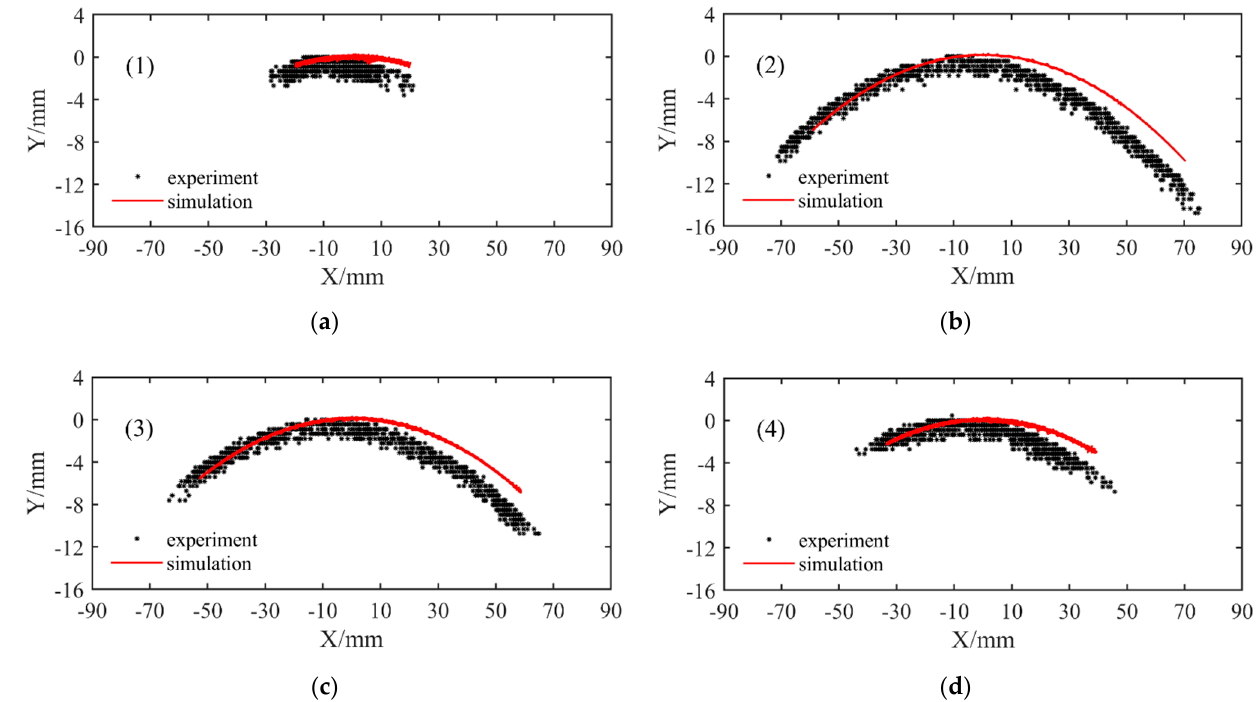
Figure 6. Movement track of the trace point of physical experiment and numerical mode under four group waves. ( a ) Wave case (1); ( b ) Wave case (2); ( c ) Wave case (3); ( d ) Wave case (4). The origin of the coordinates is the position of the tracer when the floating reef is stationary.